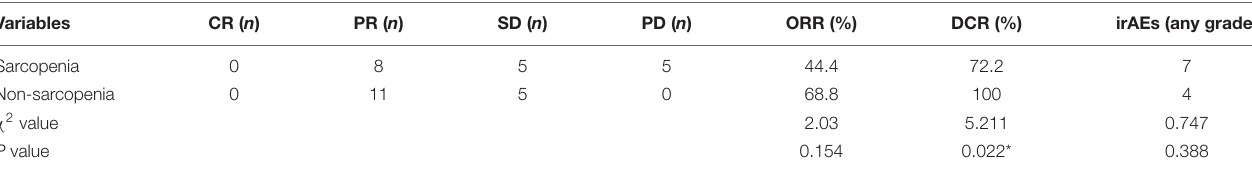
Chi-Square Test. CR, complete response; PR, partial response; SD, stable disease; PD, progressive disease; ORR, objective response rate; DCR, disease control rate; irAEs, immunotherapy-related adverse events. *Indicates significant difference.